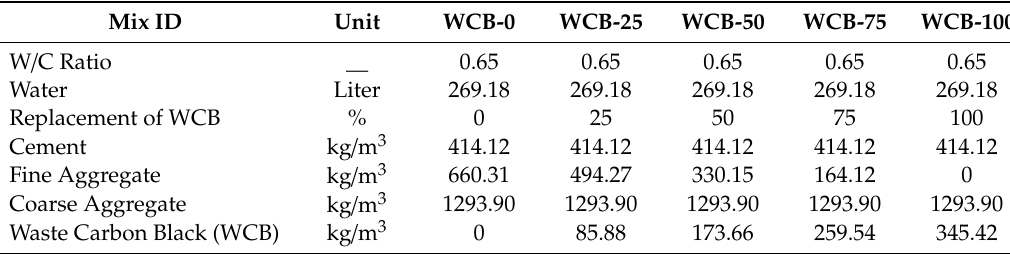
Table 4. Mix proportion of Waste Carbon Black (WCB) Lightweight Concrete .